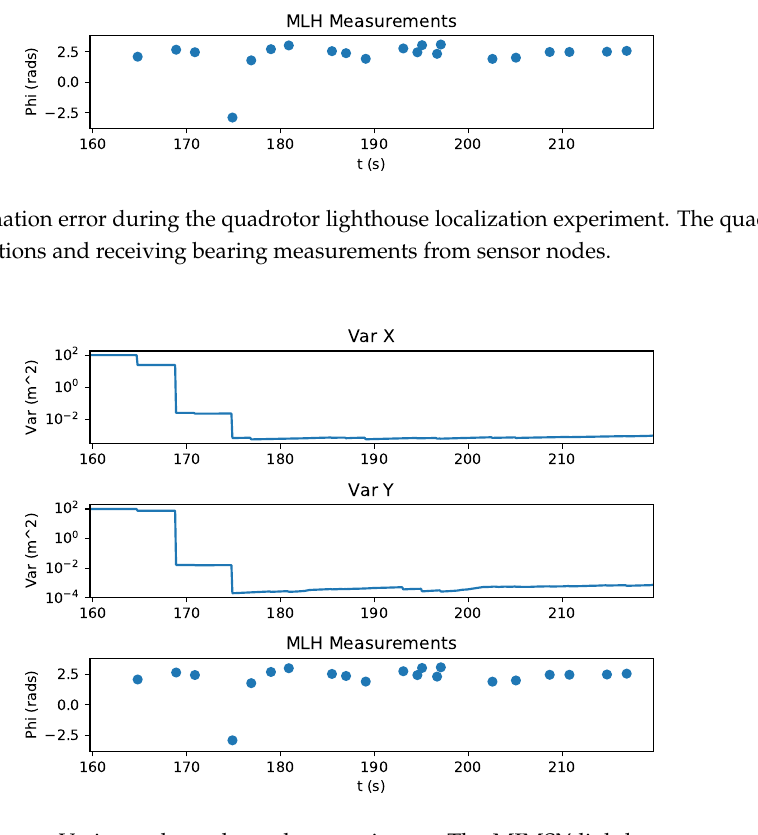
Figure 12. Estimator Variance throughout the experiment. The MIMSY lighthouse measurements (MLH) decreased the estimated variance of the x and y states, as expected.